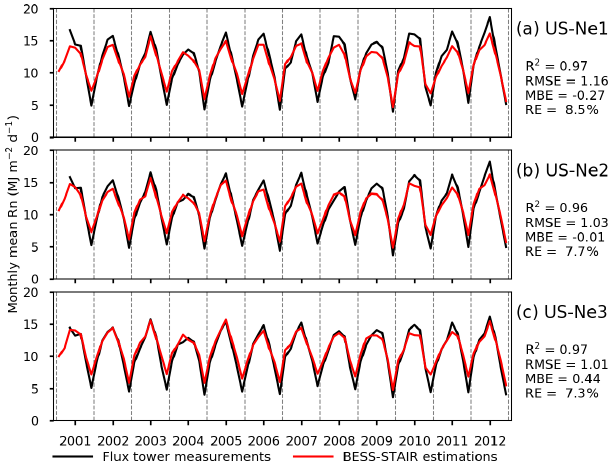
Figure A3. Time series of monthly mean Rn from flux-tower mea- surements and BESS-STAIR estimations.